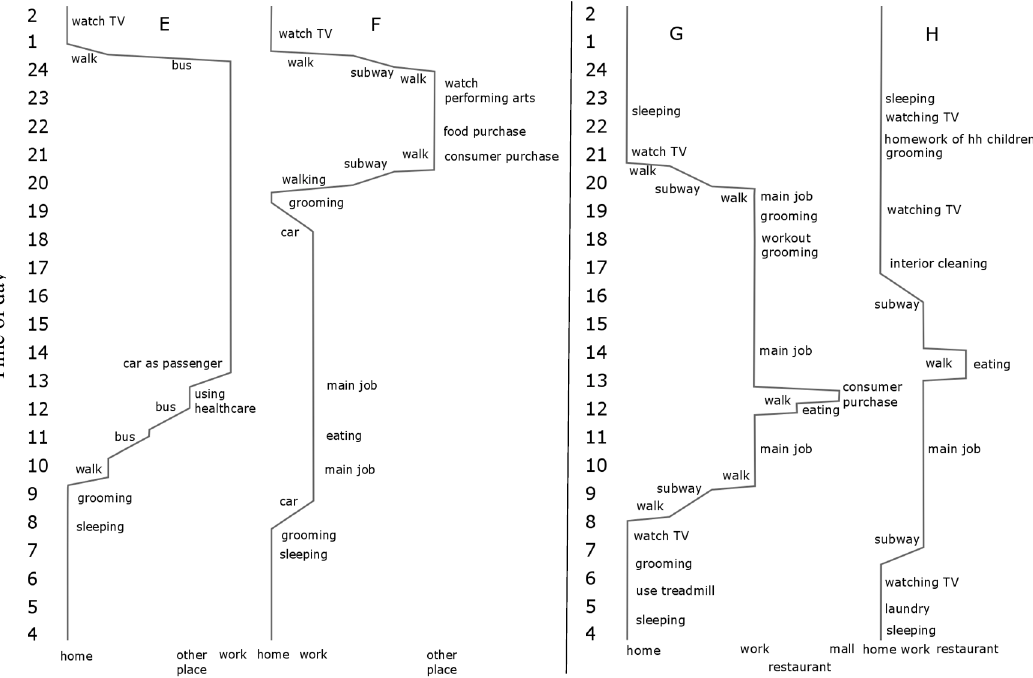
Figure 4. Activity patterns of two sample working individuals riding public transport with travel time equal to average of top 20% (E and F) and bottom 80% (G and H). The Y -axis represents time of day, starting from early morning at the bottom and time running upward by hour. The vertical length of a line is the duration of an activity. A discrete X axis represents location of an activity (hh = household), the left-hand vertical line is home, vertical lines to the right of this are workplace, restaurant, or other location. Slanted lines refer to travel between locations.